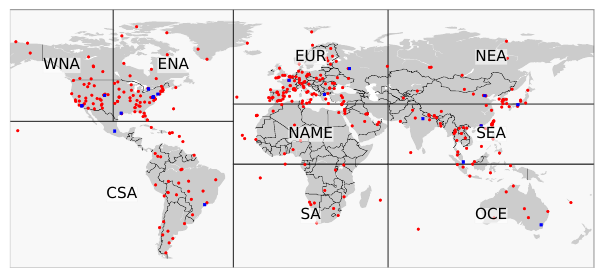
Figure 1. Regions used in the evaluation of the algorithm: West North America (WNA), East North America (ENA), Central and South America (CSA), Europe (EUR), North Africa and Middle East (NAME), South Africa (SA), Northeast Asia (NEA), South- east Asia (SEA), and Oceania (OCE). The red and blue dots show positions of all the AERONET stations used in the comparisons. The blue dots indicate stations classified as an urban station in the